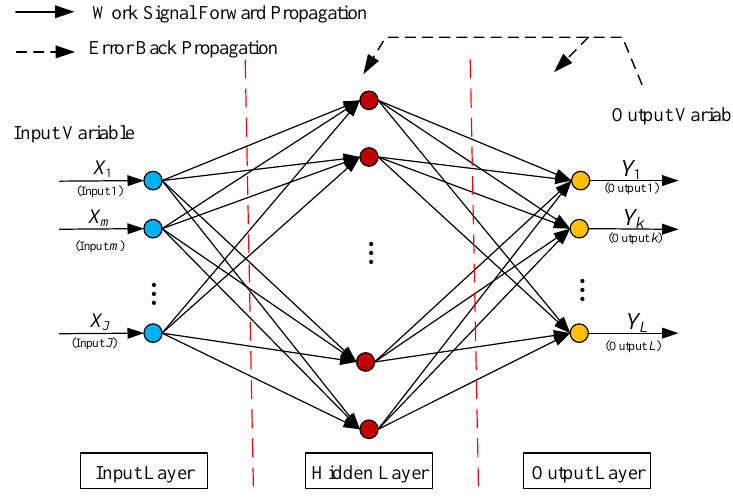
Figure 5. The topology of BPNN.